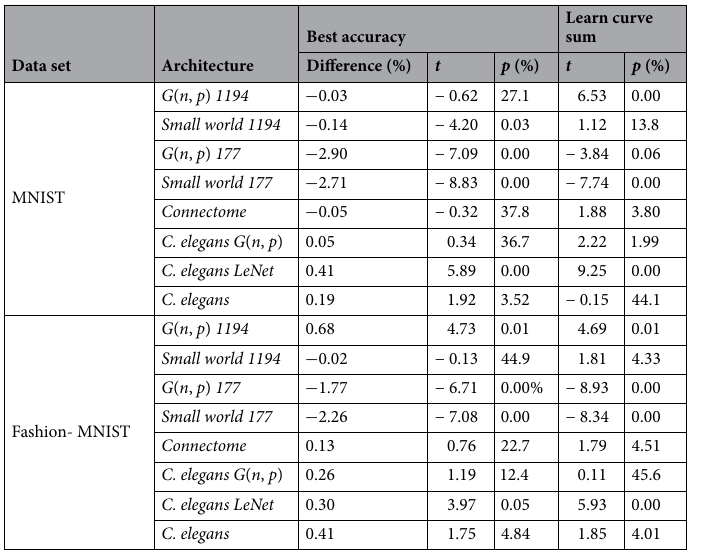
Table 3. Accuracy and learn curve sum t-test for ‘ structure implantation is better than winning ticket ’ (negative values indicating winning ticket is better than structure implantation ).